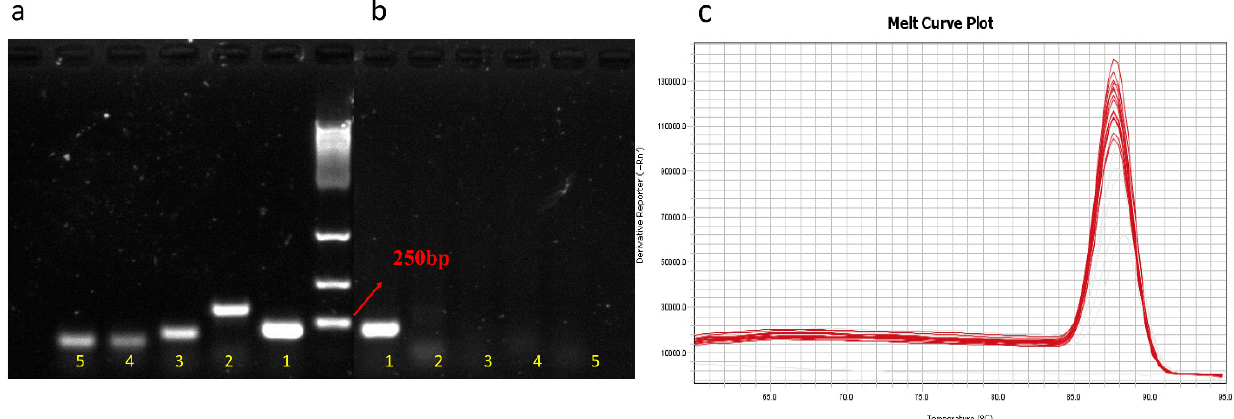
Figure 1. The primer set Cbtu-1 had high specificity. ( a ) All primer sets give positive results in a single system for PCR amplification (Primer sets 1, 2, 3, 4, and 5 are the same as Table 1). ( b ) Primer set Cbtu-1 amplifies the target product accurately in the complex system of intestinal microbial genomic DNA with a product length of 213 bp. ( c ) The melting curve plot of RT-qPCR amplification of primer set 1 is a single peak.